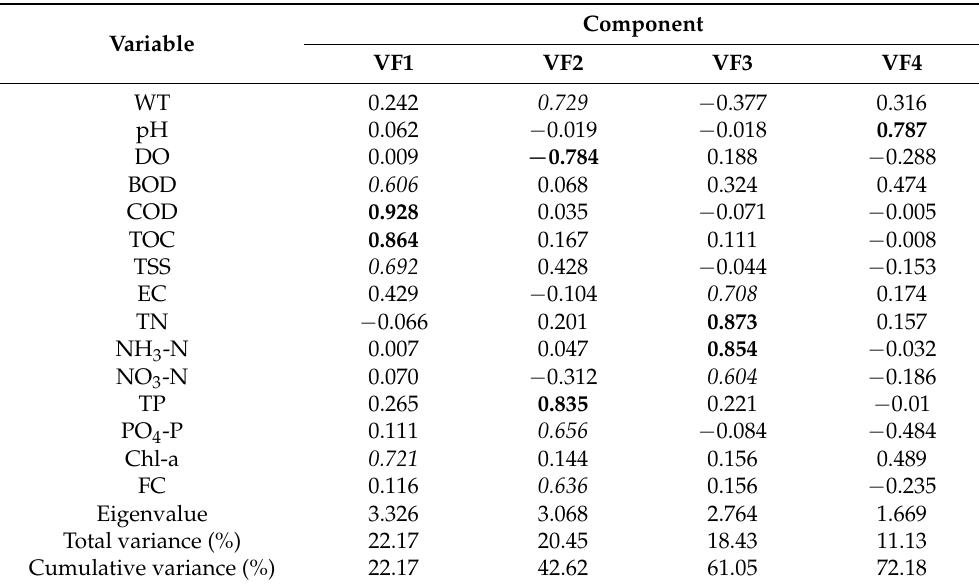
Table 2. Variable loads for the major components of all data are based on the principal component analysis (PCA) and factor analysis (FA).